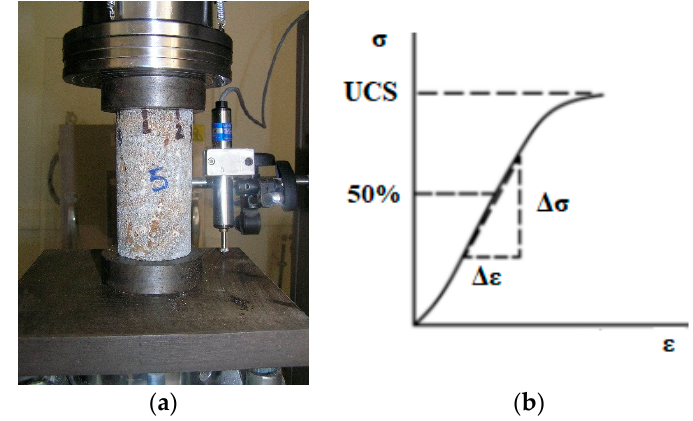
Figure 5. ( a ) Cylindrical specimen subjected to loading; ( b ) Stress-strain curve for the determination of UCS and E t .